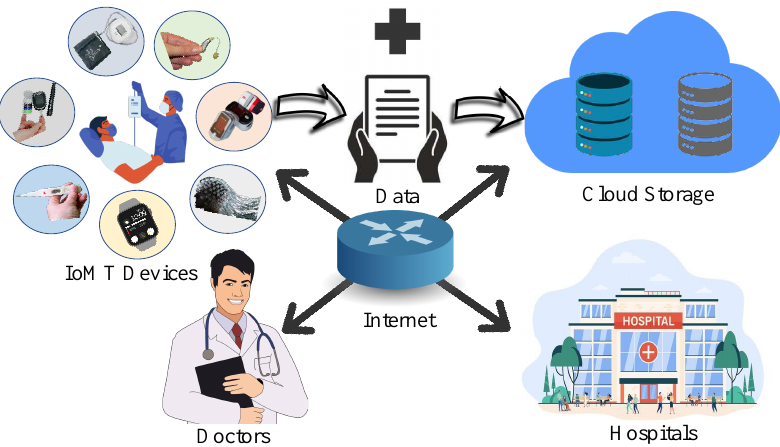
Figure 3. Security and privacy of IoMT